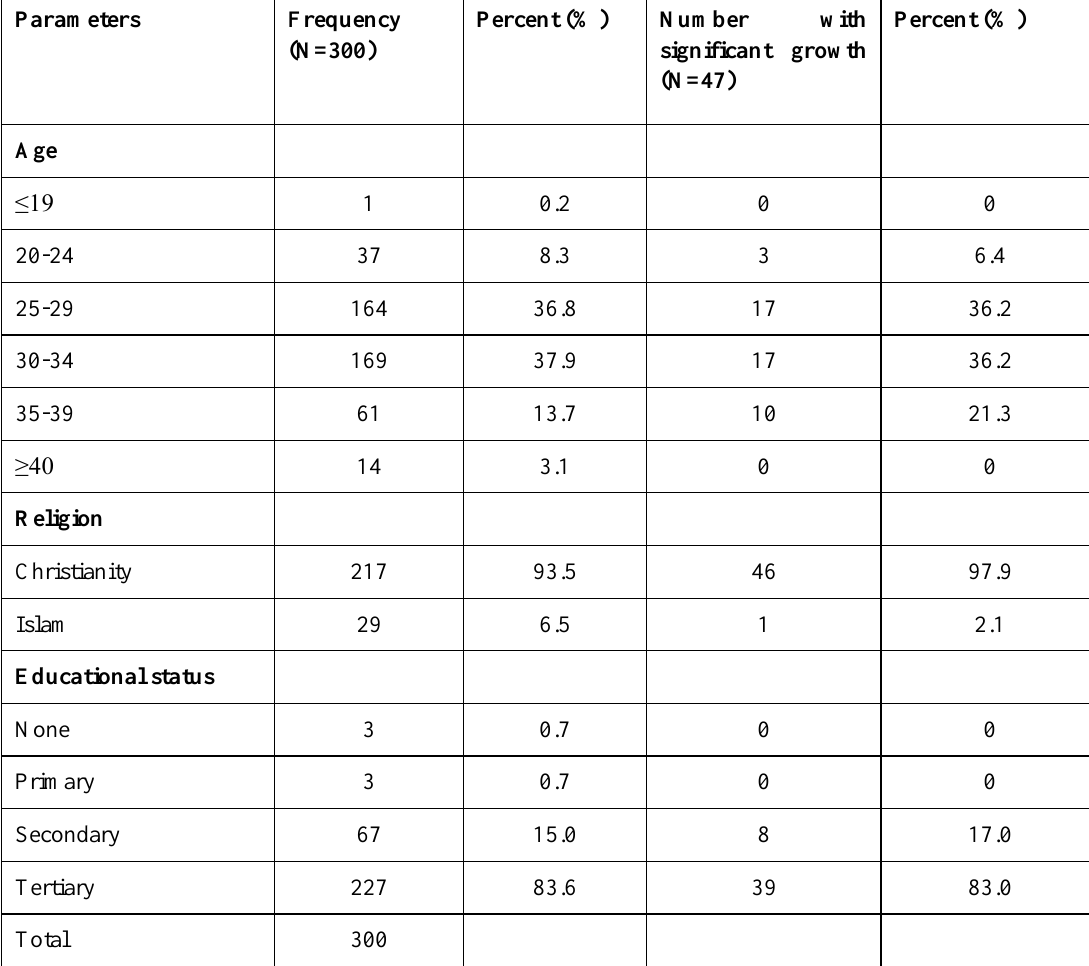
Table 2. Socio-demographic characteristics of the population. Parameters